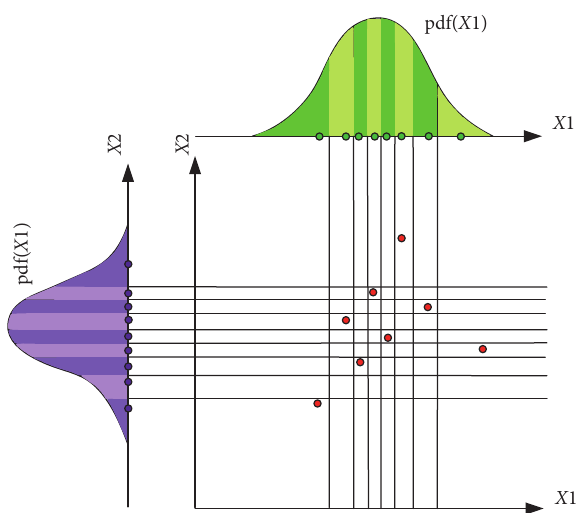
Figure 19: Schematic of two-variable LHS with 8 samples.